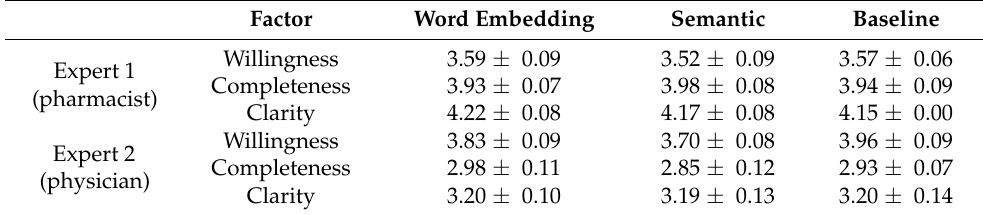
Table 2. Descriptive statistics of three